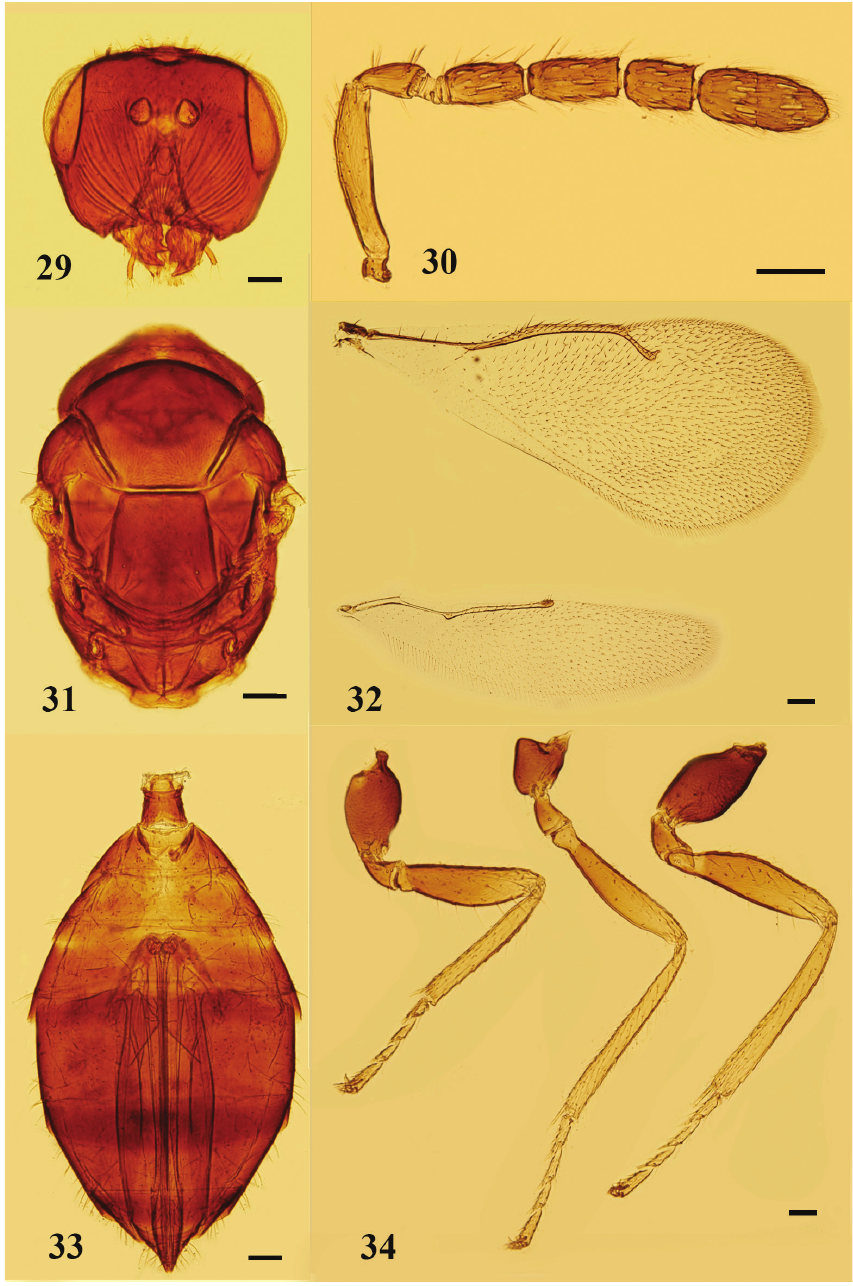
31 mesosoma, dorsal view 32 fore and hind wings, dorsal view 33 metasoma, ventral view 34 legs, lateral view, from left to right: fore, mid, and hind legs. Scale bars: 100